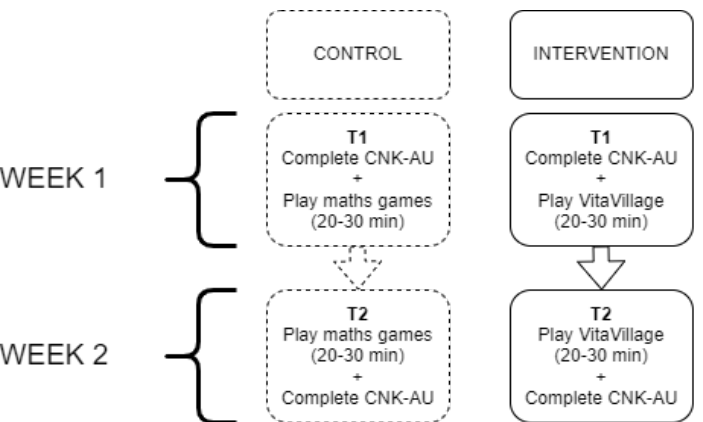
Figure 5. Flowchart of study design. CNK-AU: the Child Nutrition Knowledge Questionnaire – Australian version.